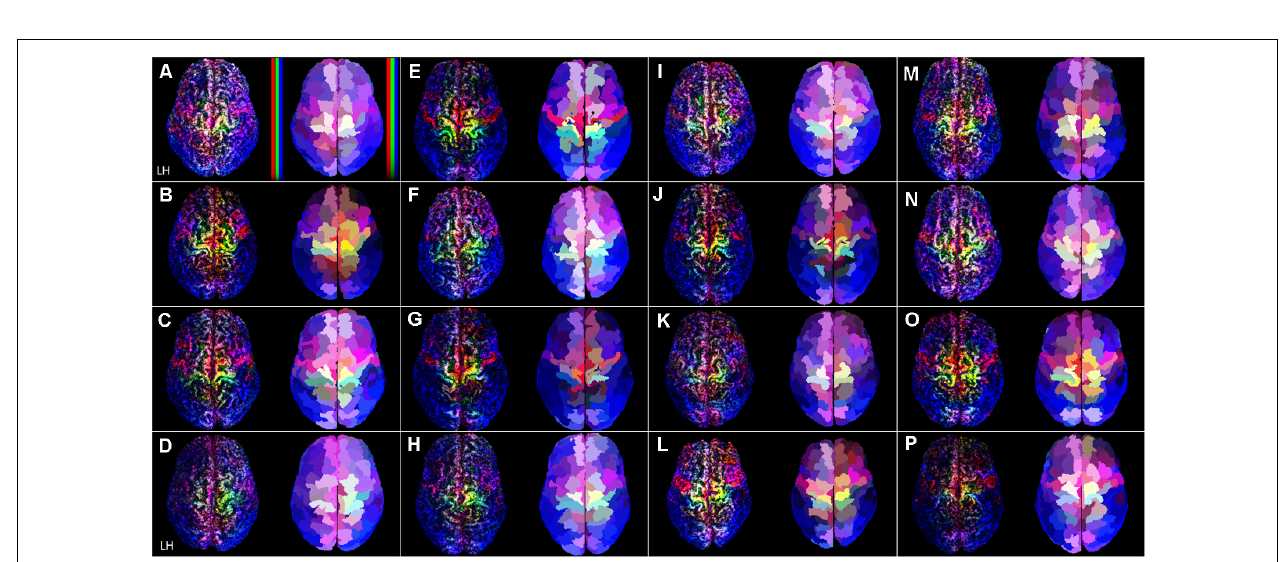
FIGURE 2 | The TDRM from all 16 datasets in the superior view. In each image box, the left figures are the unit-sized voxel (1 mm 3 ) based TDRMs, and the right figures are parcellation-piece-based TDRMs. In panel (A) , non-linear scaled color bars represent mapping density in each type of fiber track (tracks for commissural fiber = red, projection fiber = green, association fiber = blue). The capital letters in each image box (A–P) indicate the dataset ID (see Supplementary Table 2 ). TDRM, track-density ratio map.